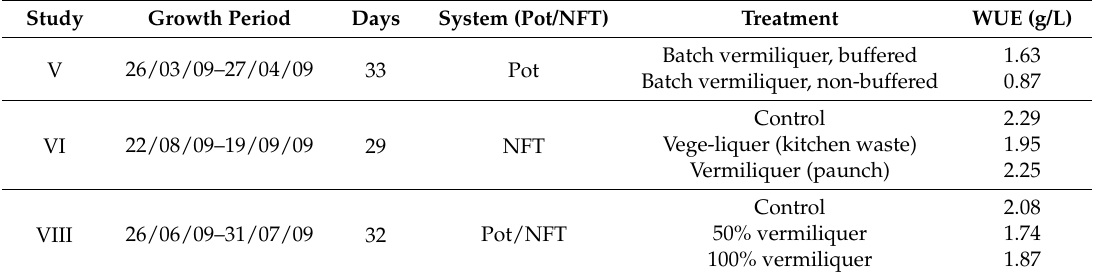
Table 4. Water use efficiency (WUE), calculated as total dry weight (root plus shoot) per unit of accumulated water used by evapo-transpiration in three